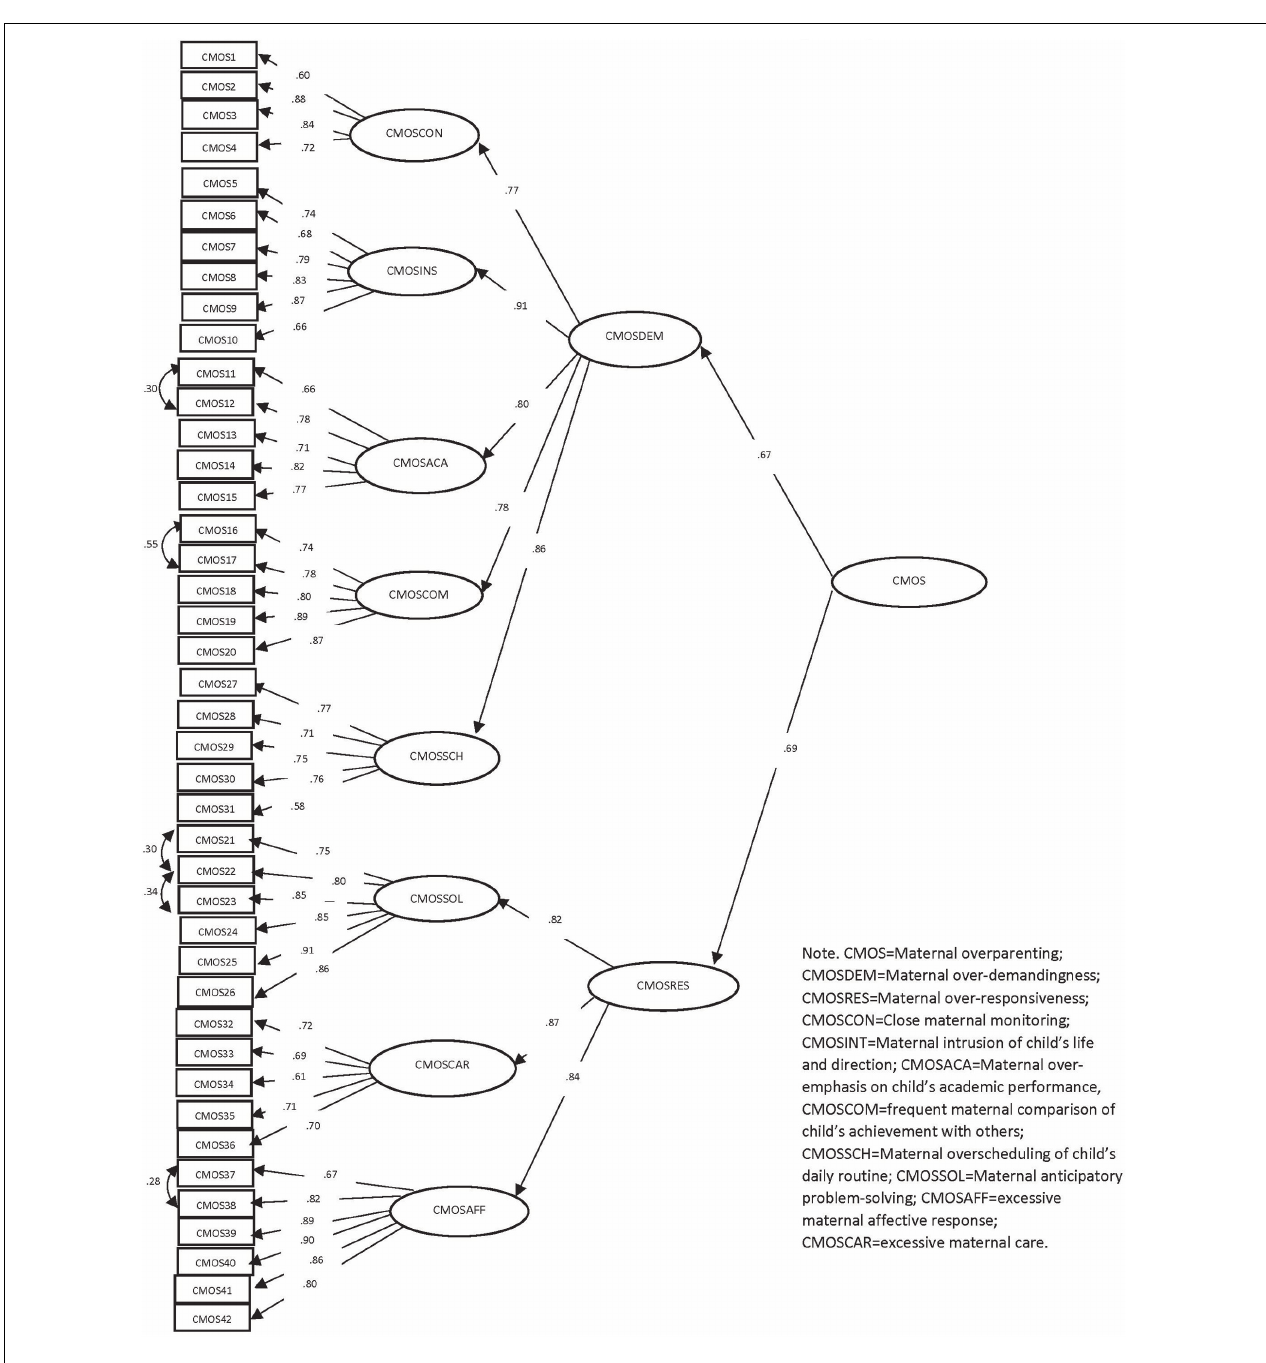
FIGURE 2 | Factor structure and standardized coefficients of chinese Maternal Overparenting